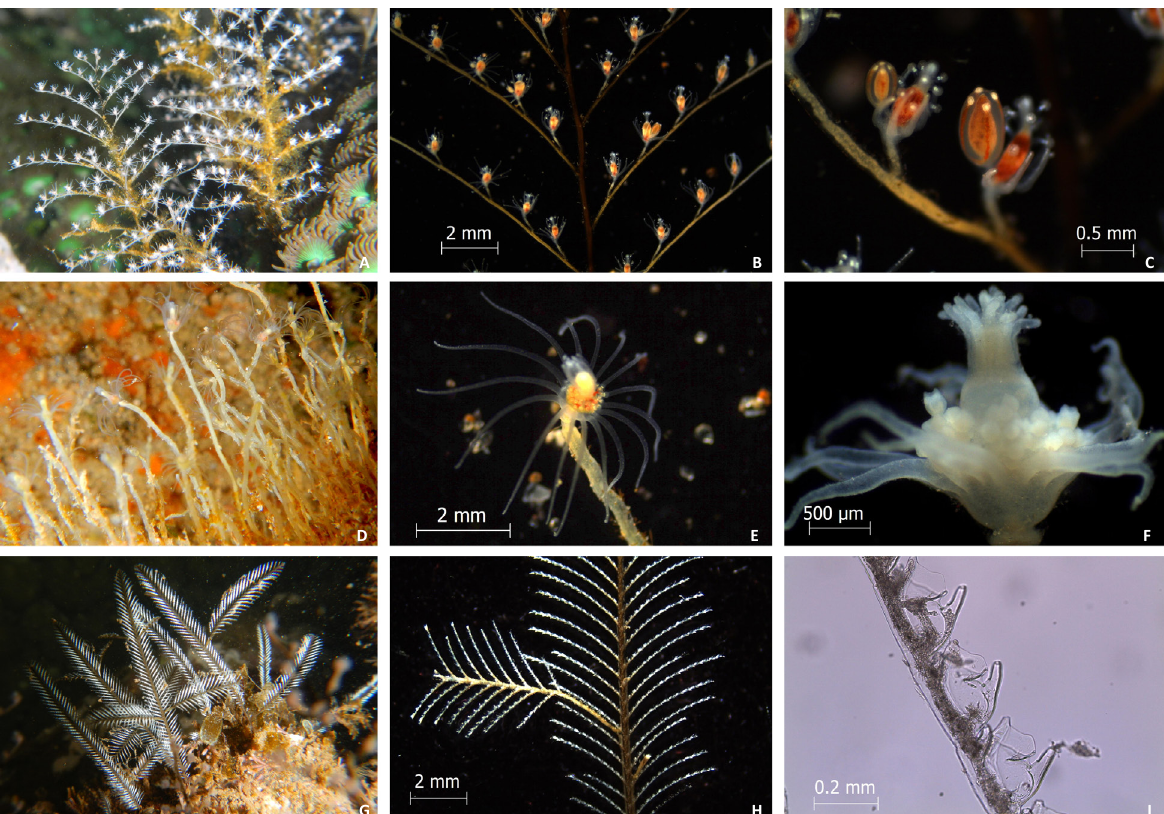
Image 2. Pennaria disticha (A) Colonies in the rockpool, (B) Arrangement of hydrocladia, (C) Hydranth with budding medusae; Ectopleura viridis (D) Colonies in the rock pool, (E) Hydranth (before preservation), (F) Hydranth (after preservation) showing arrangement of tentacles in two whorls and presence of medusa buds; Macrorhynchia philippina (G) Colonies in the rock pool, (H) Arrangement of hydrocladia, (I) Hydrotheca. © Pooja